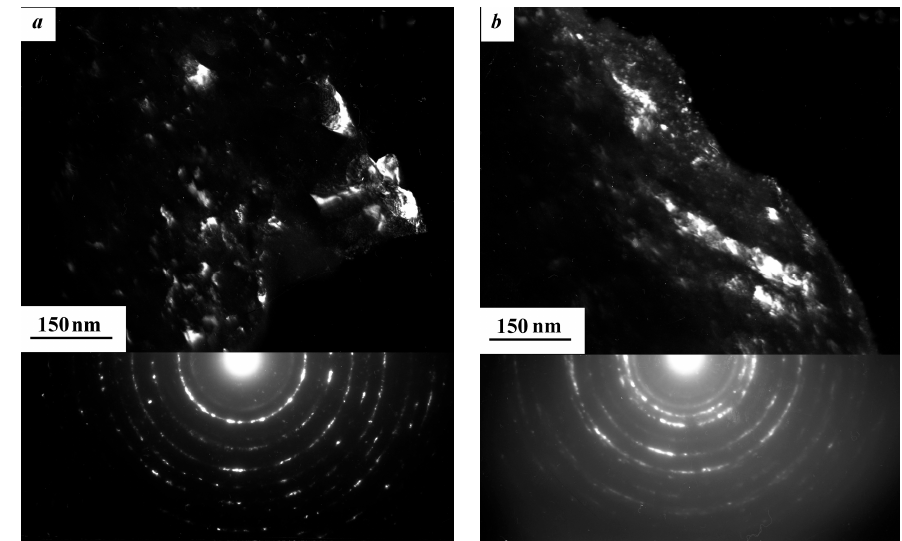
Figure 4. Dark-field images (TEM) and SAED patterns of α -Fe ( a ) and α -Co ( b ) in the Co 28.2 Fe 38.9 Cr 15.4 Si 0.3 B 17.2 AA subjected to HPT to N = 2.